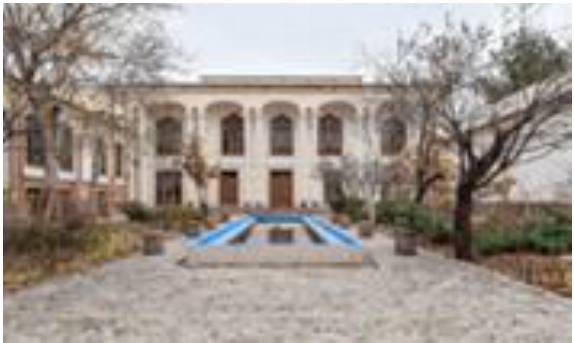
Figure 4 Courtyard house No. 3 (Source: Iran Cultural Heritage, Handicrafts and Tourism Organization)